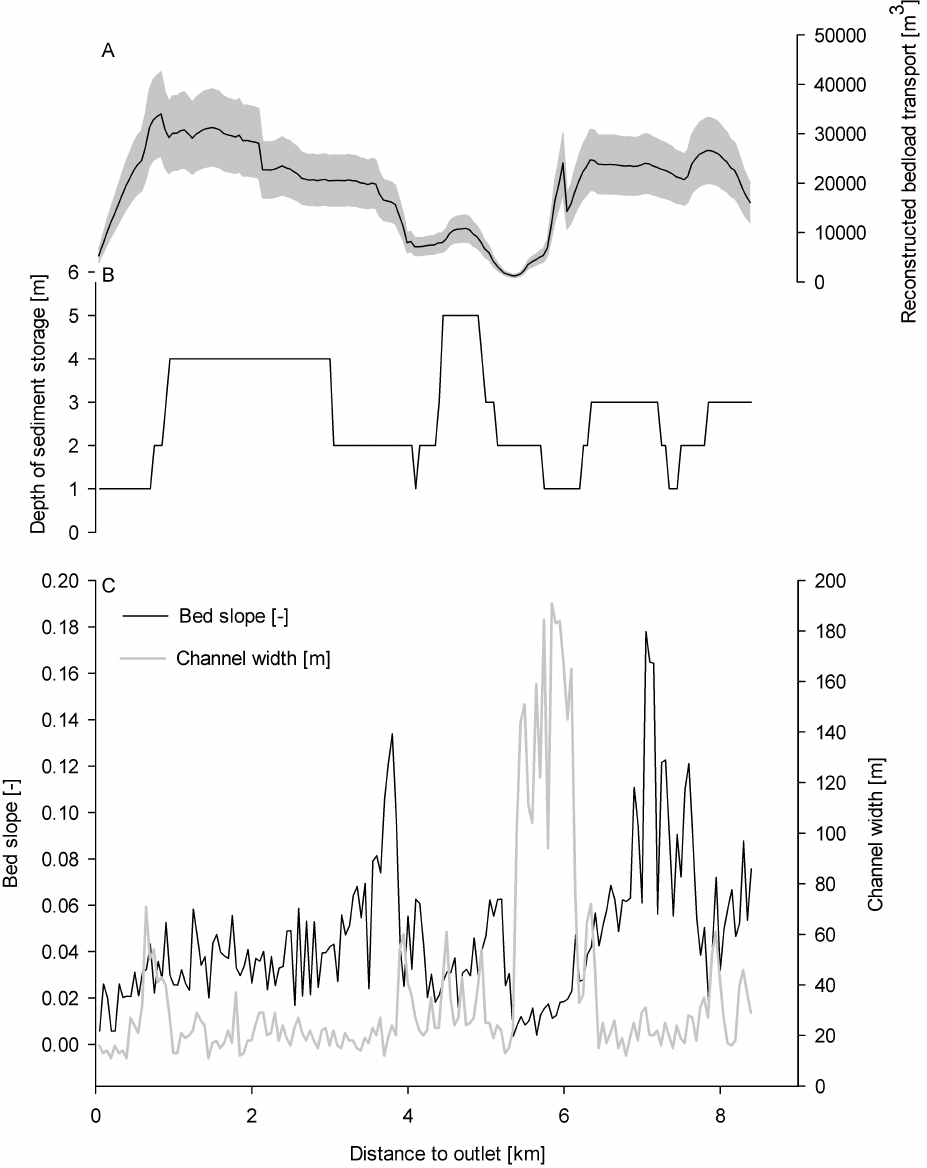
Fig. 2. Properties of the Chiene river and observations of bedload transport. A : Reconstructed bedload transport, the grey band indicates a ± 25% error band, B : initial depth of sediment storage, C : bed slope of the river and channel